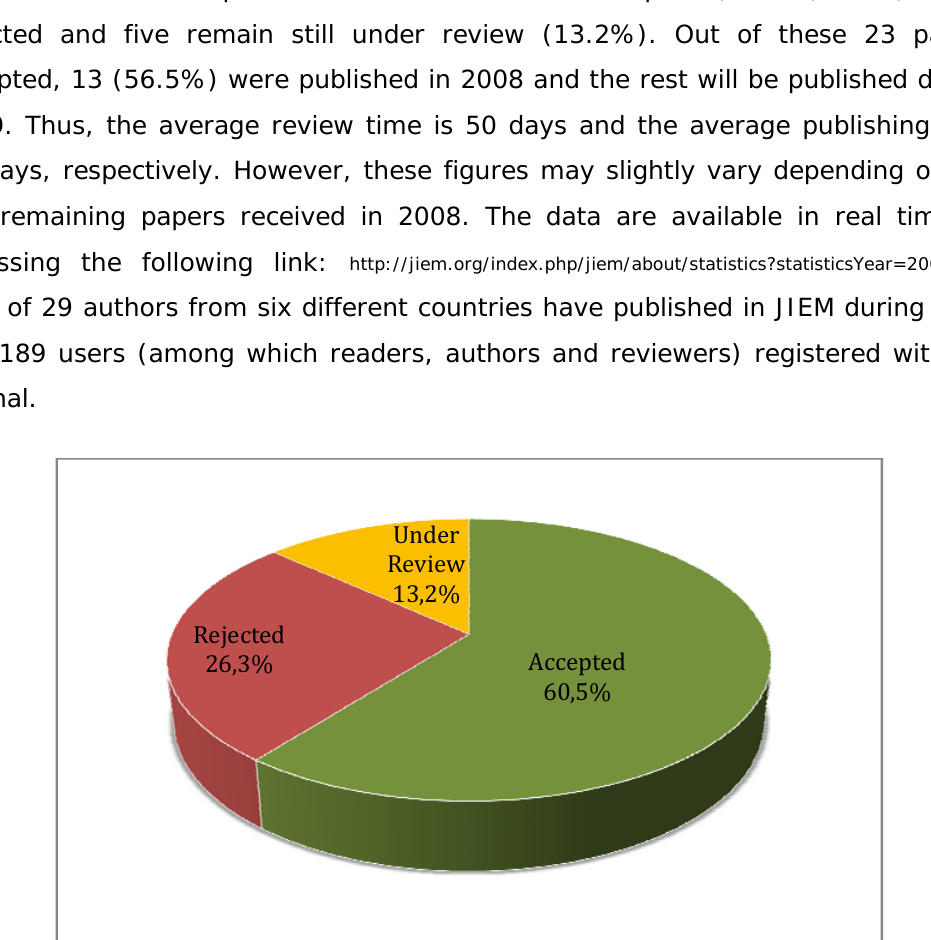
Figure 1. “Papers received during